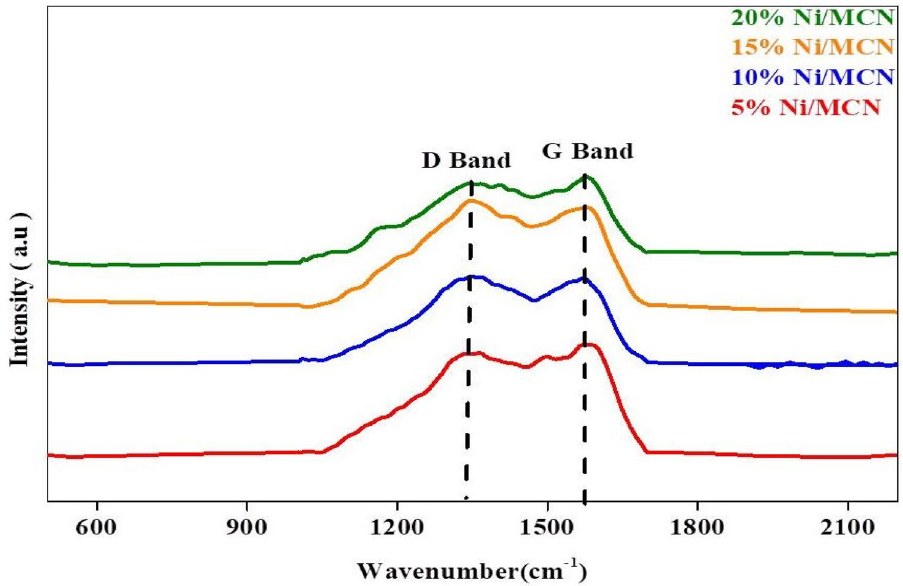
Figure 5. Raman spectra of the prepared samples.